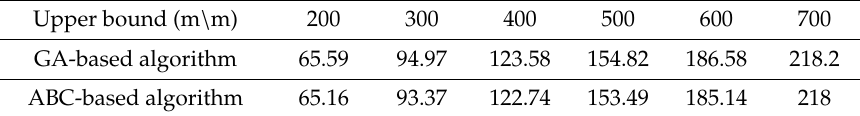
Table 2. Average location errors versus the upper bound of the NLOS errors.